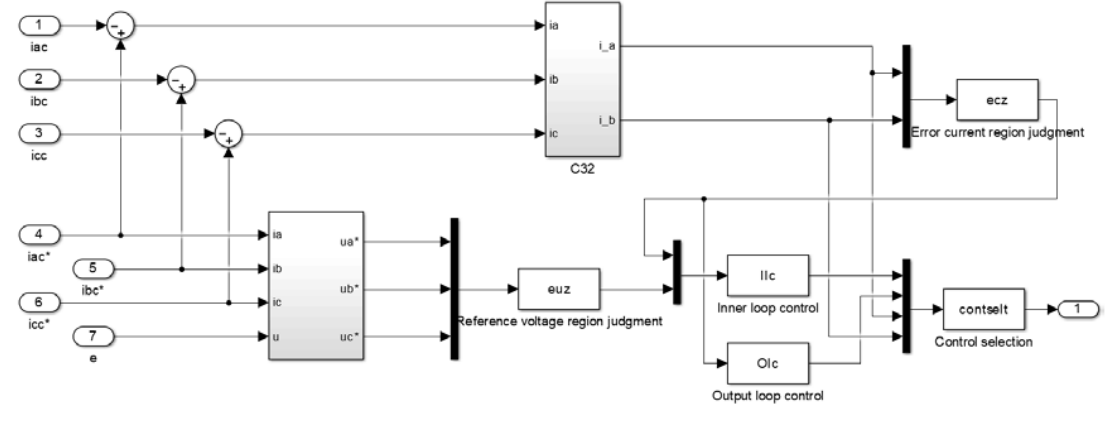
Figure 4. Improved hysteresis control simulation model.